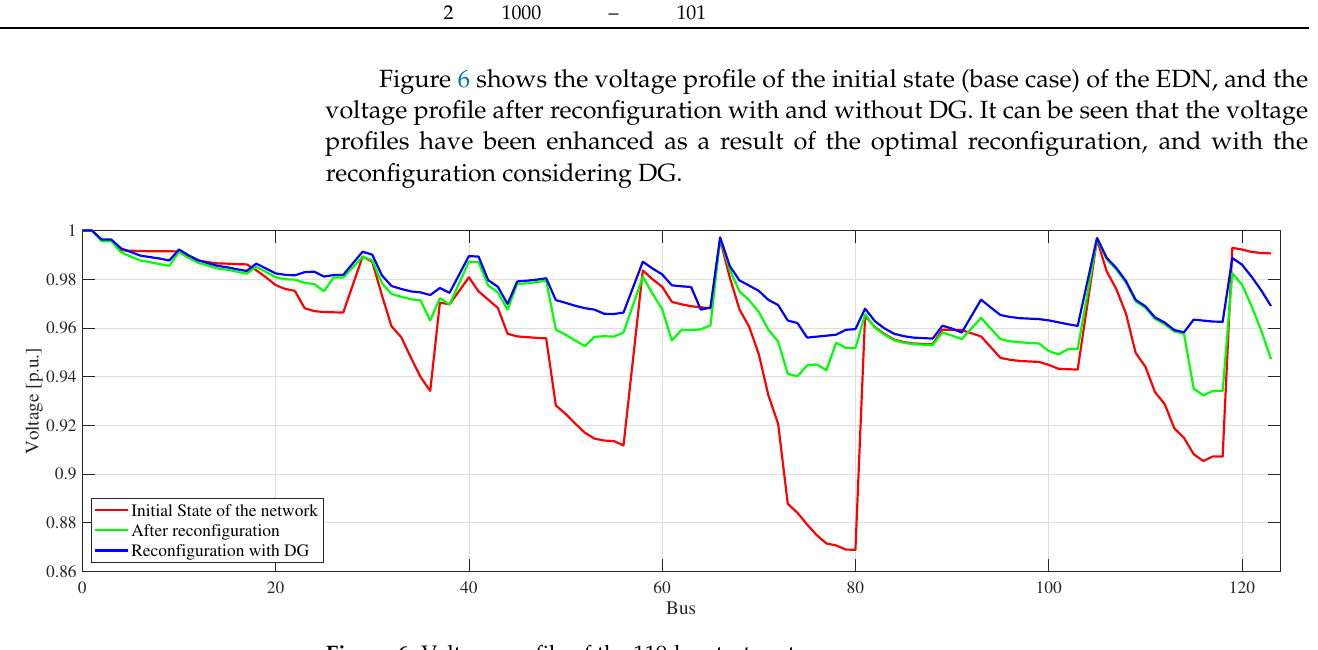
Figure 6. Voltage profile of the 119-bus test